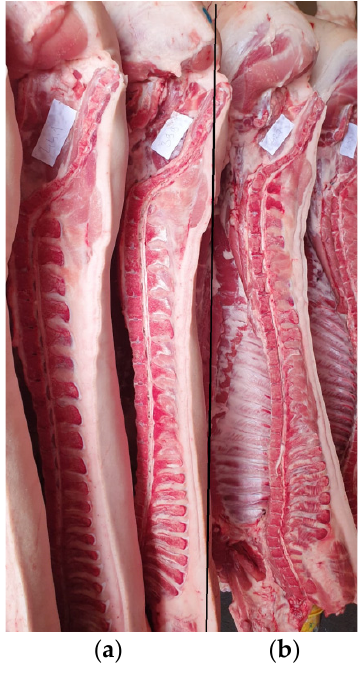
Figure 1. Pork from trial ( a ) and control ( b ) group pigs. Higher crude protein content in muscle tissue (2%) and cholesterol in fat was ob ‐ served in pork from trail group, but the difference was not significant ( p > 0.05) (Table 5). Table 5. Content of crude protein, fat, ash in muscle, and cholesterol in fat (in dry matter). Traits Control Group Trial Group p Value Crude protein content in muscle, % 83.54 ± 3.81 Fat content in muscle, % 8.30 ± 0.43 a Ash content, % 6.15 ± 0.22 a 0.01 Cholesterol content in fat, % 0.30 ± 0.01 0.31 ± 0.01